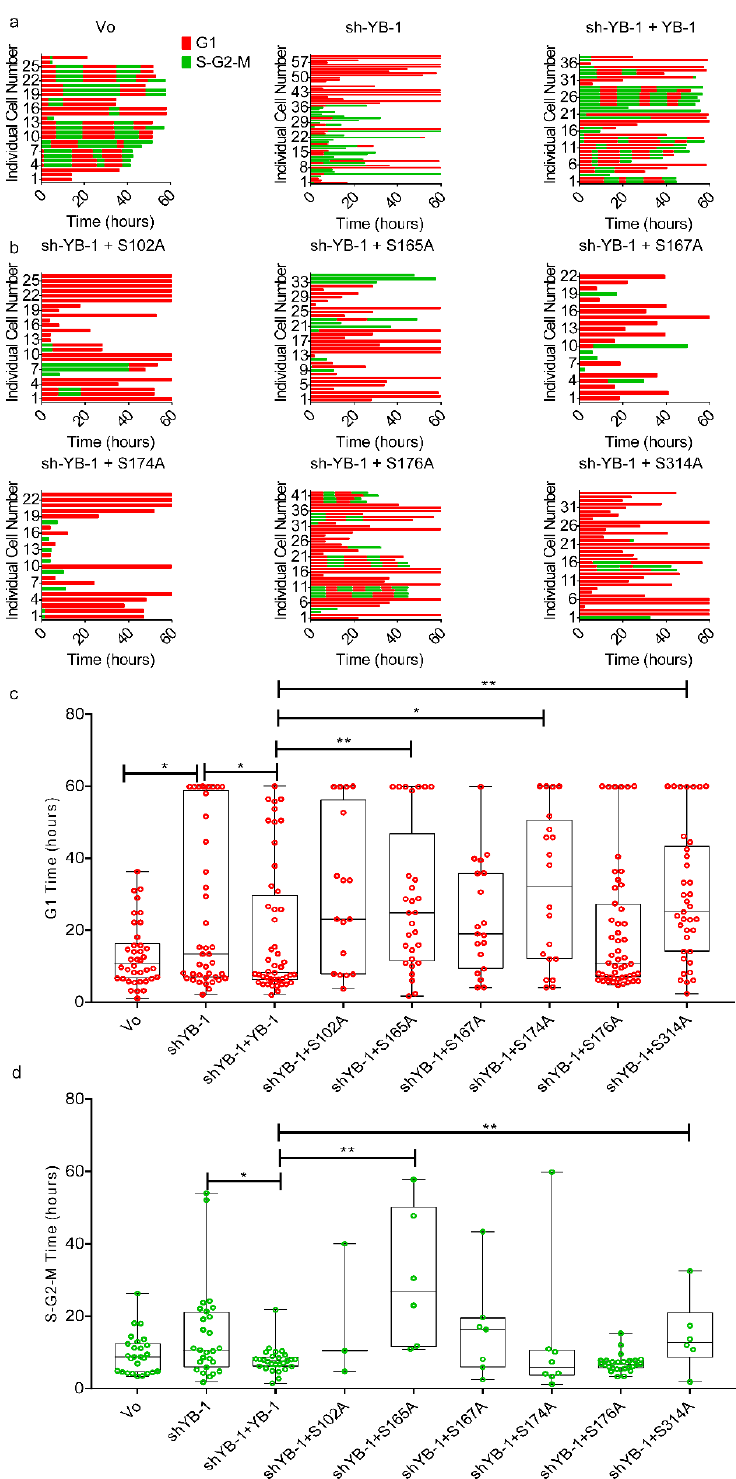
Figure 7. Phosphorylation defective YB-1 mutants do not rescue from cytokinesis failure. ( a , b ) Shows the starting phase of the cell cycle for each tracked A549 / F cell using time lapse imaging and quantitates the amount of time spent in each phase of the cell cycle and the number of divisions that each cell undergoes. ( c ) Quantitation of G 1 phase transit time. ( d ) Quantitation of S-G 2 -M phase transit time. ( c , d ) Significance was determined using the Mann–Whitney U test, * p < 0.05, ** p < 0.01, *** p < 0.001 and **** p <